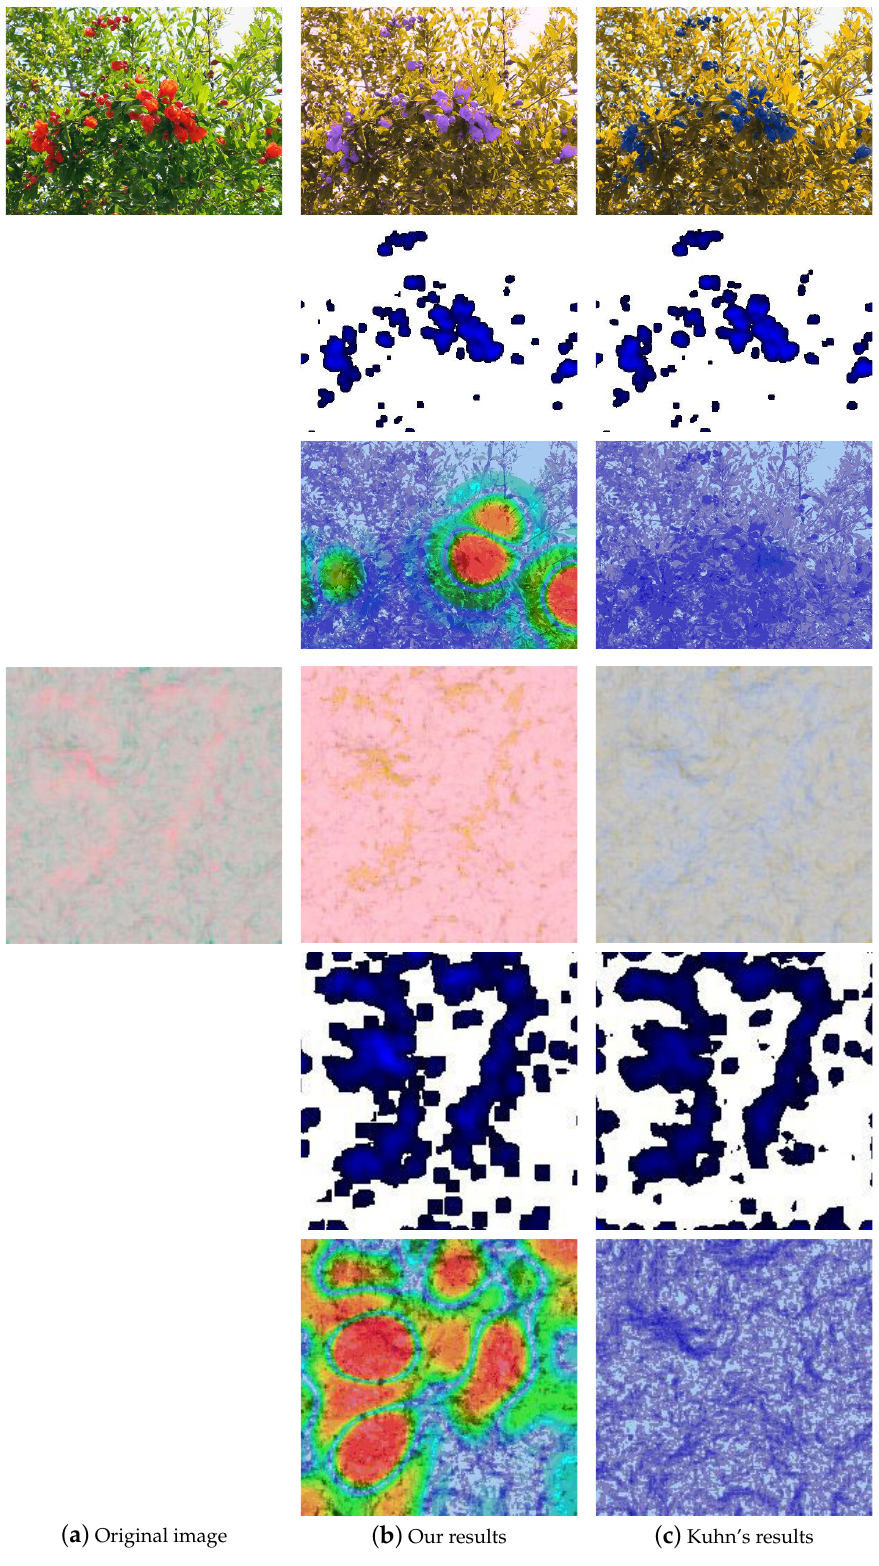
Figure 16. The comparison of CVD simulation results processed using our re-coloring technique and Kuhn’s method. The first and fourth rows are two test images and their CVD simulation results. The second and fifth rows are the visualized RMS values, and HDR-VDP evaluation is shown in the third and sixth